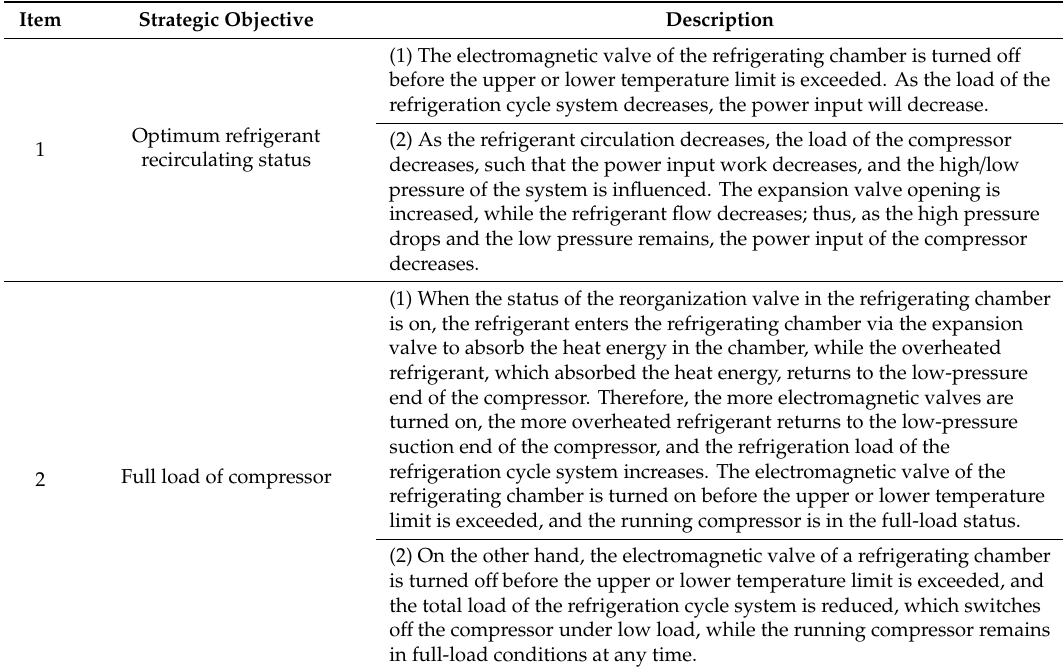
Table 1. The control strategy of refrigerating